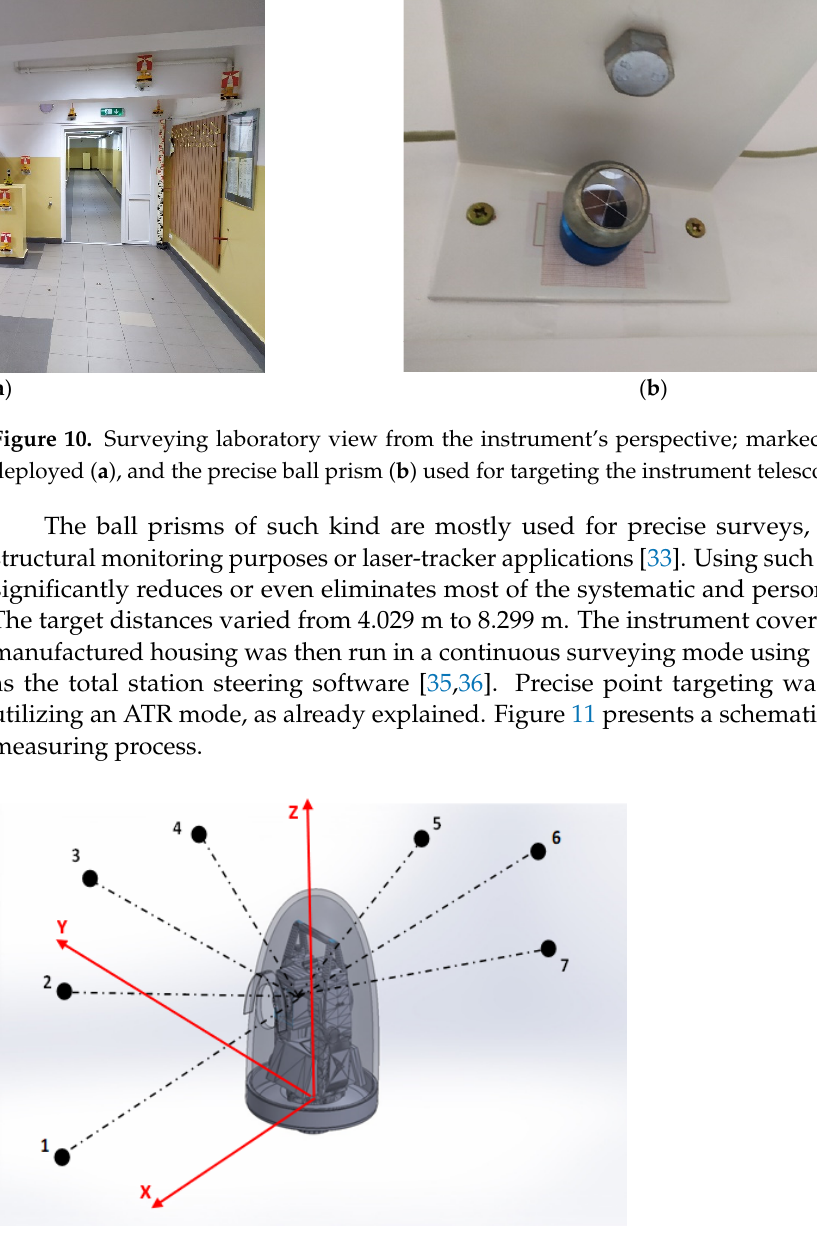
Figure 11. Scheme of the test survey performed with total station placed inside the manufactured housing in front of the directions of a local coordinate system XYZ (drawn in red). 1, 2, … 7 are control point numbers.